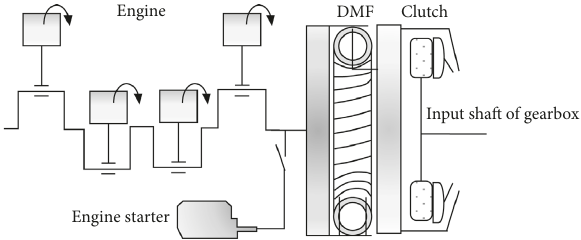
Figure 1: Schematic drawing of DMF driveline structure under start-up condition.